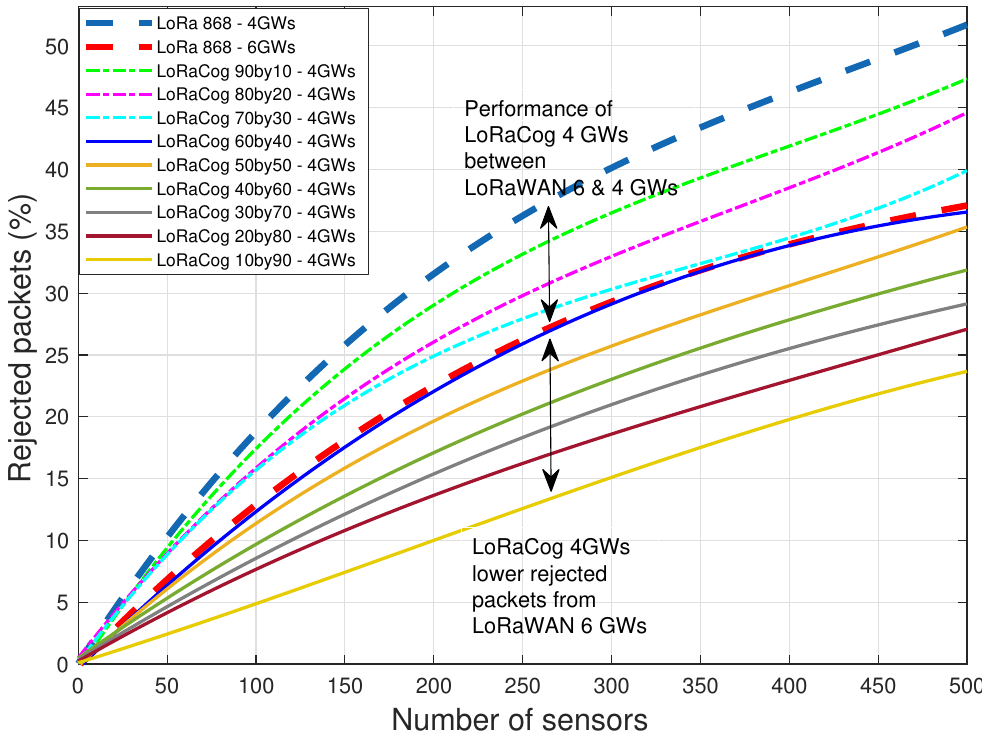
Figure 10. LoRaWAN 4 and 6 GWs vs. LoRaCog 4